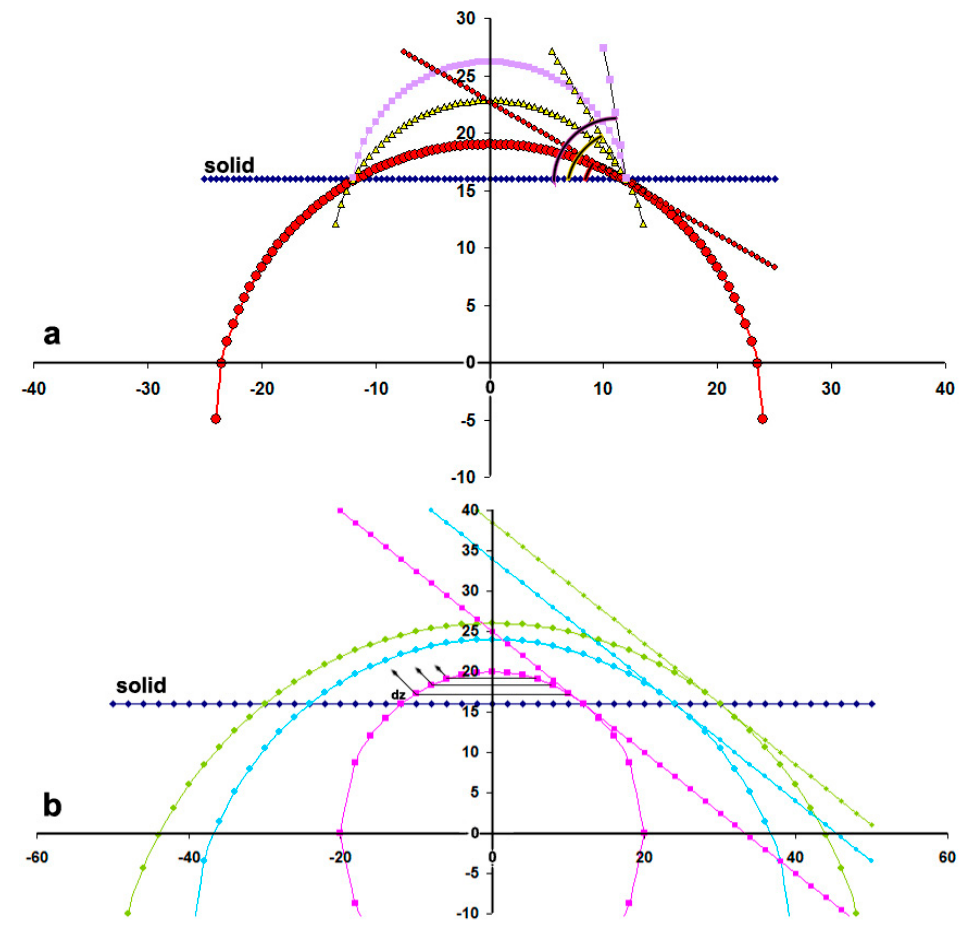
Figure 5. ( a ) Stabilization of an NB pinned on a surface. As the height and the contact angle decrease, the radius of the curvature increases and the pressure across the interface deflates. ( b ) Free-standing sNBs. Notice the general case of non-homogeneous distribution of the dissolved gas. By dividing the bubble into slices of thickness (dz) and by ignoring the gas concentration in the liquid, the bottom slices show the largest contribution to gas exchange according to Equation (12).